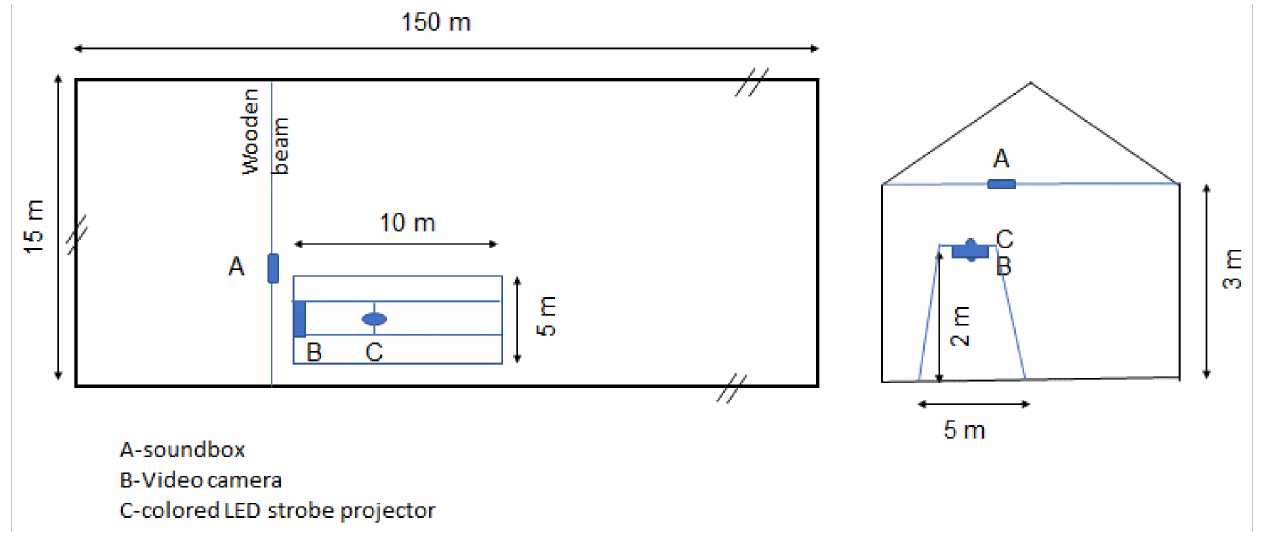
Figure 1. Schematic view of the experiment showing a tripod metal structure built in the house’s center to support the video camera and the colored LED strobe projector. The soundbox was fixed in the structural wooden beam near the